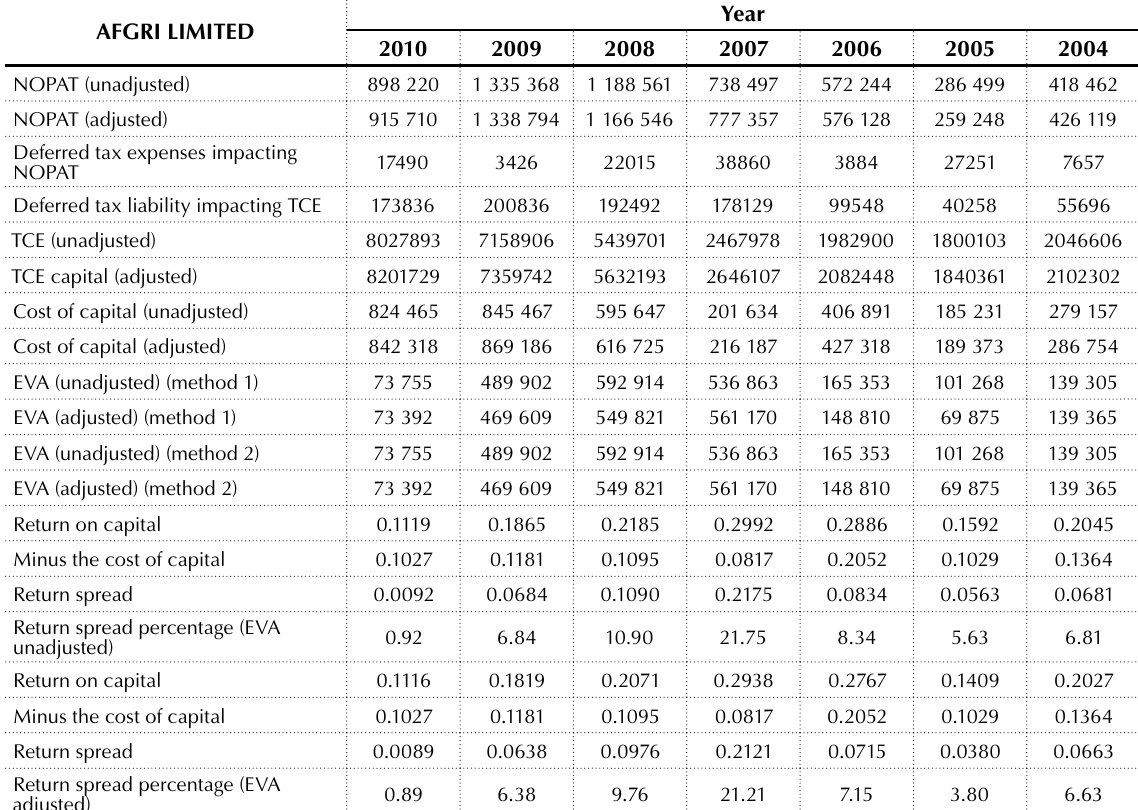
Table A1 (cont.). EVA and deferred tax analysis (sample company: AFGRI